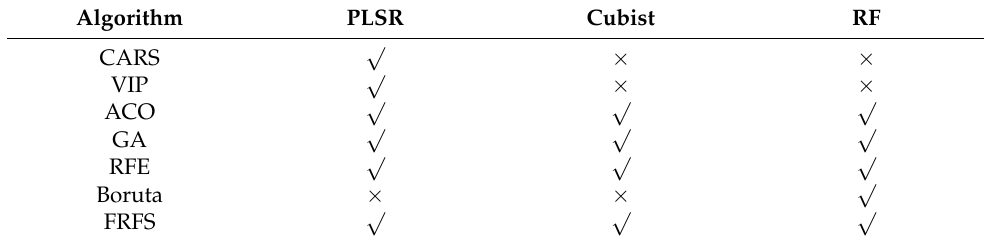
Table 1. Available algorithms for seven variable selection